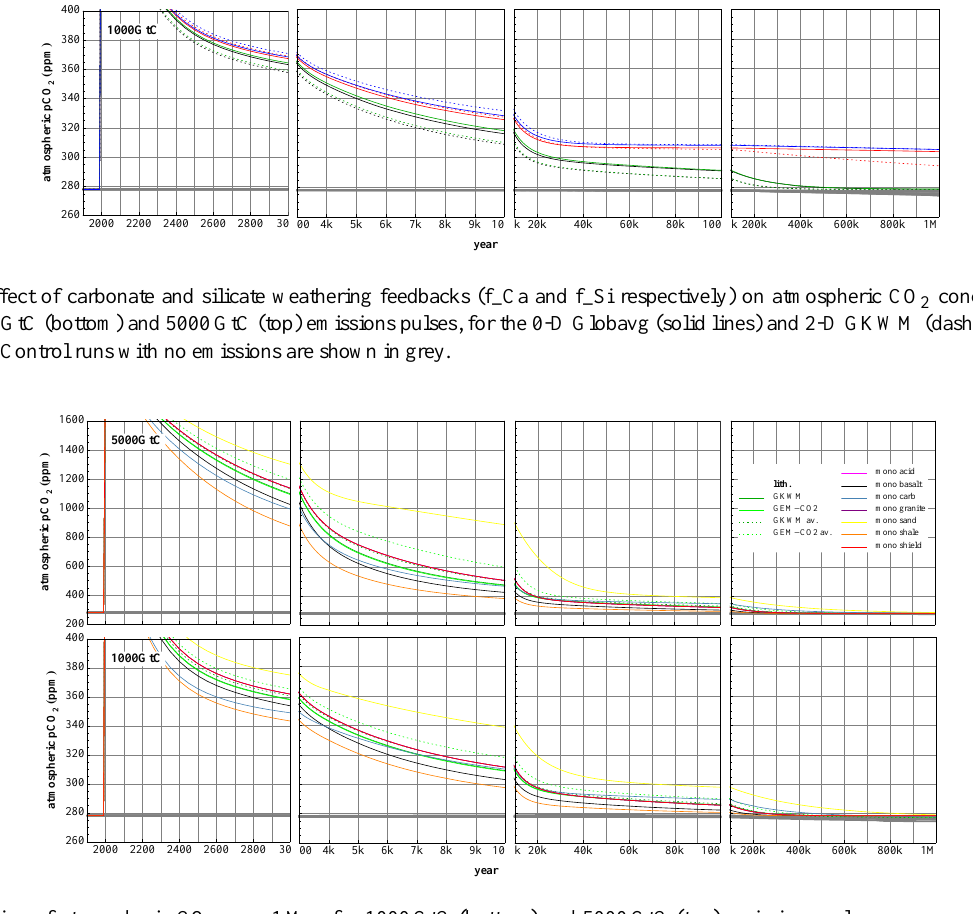
Fig. 22. Evolution of atmospheric CO 2 over 1 Myr for 1000 GtC (bottom) and 5000 GtC (top) emissions pulses, vs. a control run with no emissions (grey lines), for different lithologies using the GEM-CO2 weathering scheme.